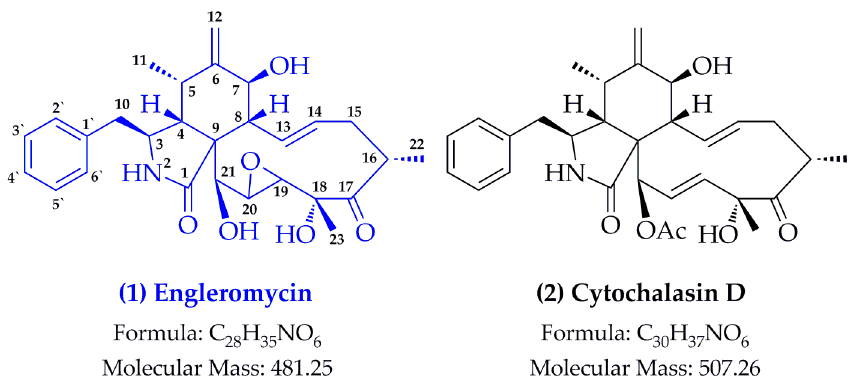
Figure 1. Structures of engleromycin and cytochalasin D.